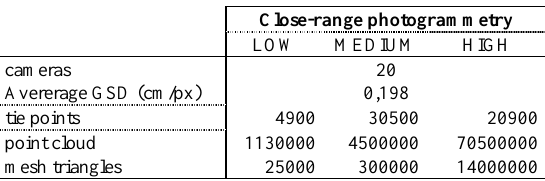
Table 2. Data processing results on close-range photogrammetry